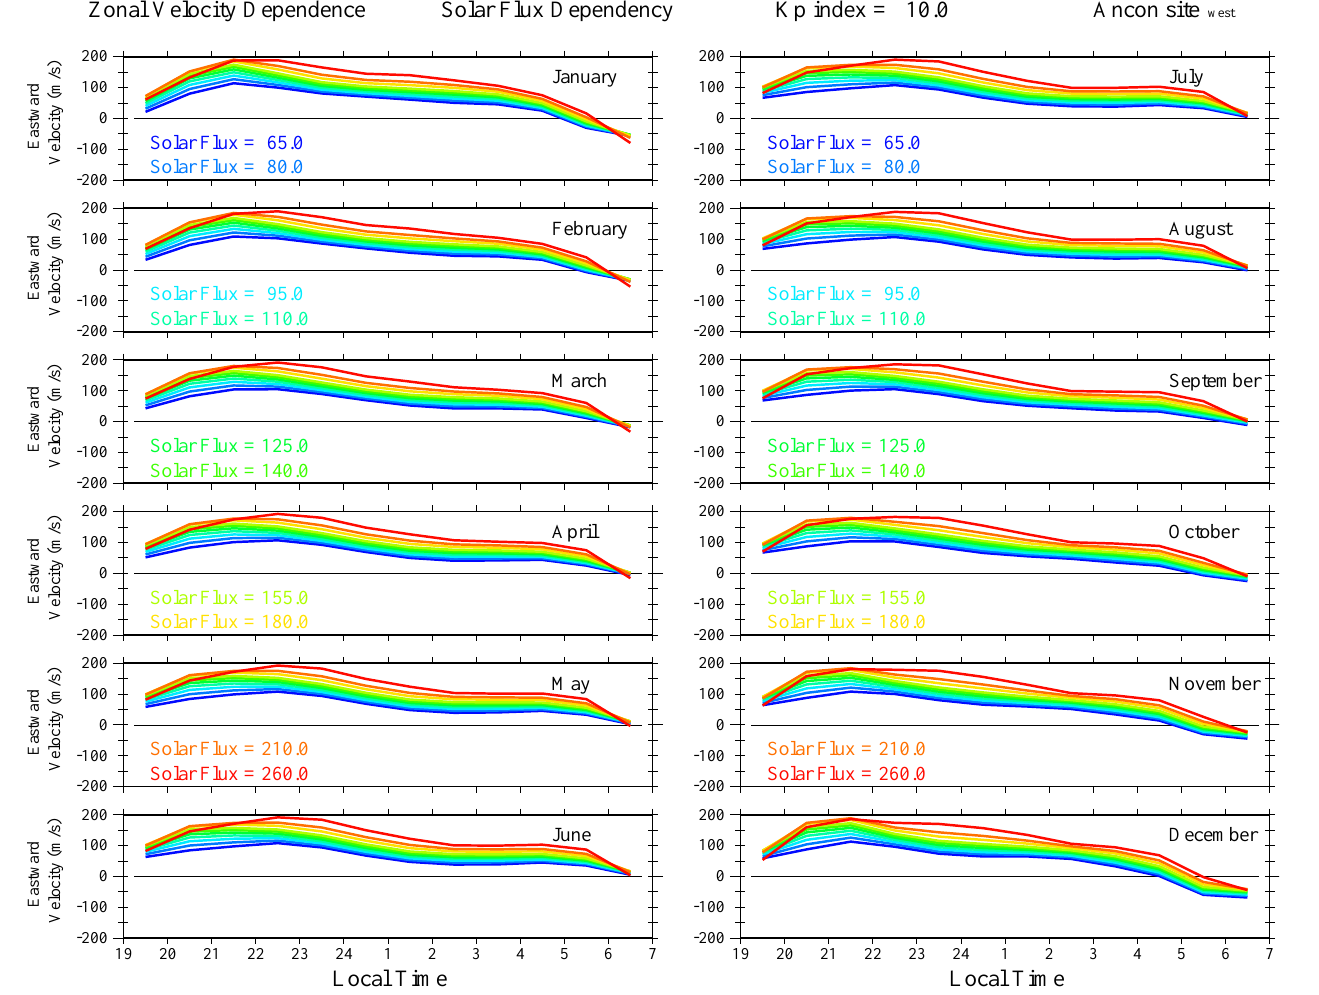
Fig. 6. (c) Ancon zonal drift dependence on solar flux, K p